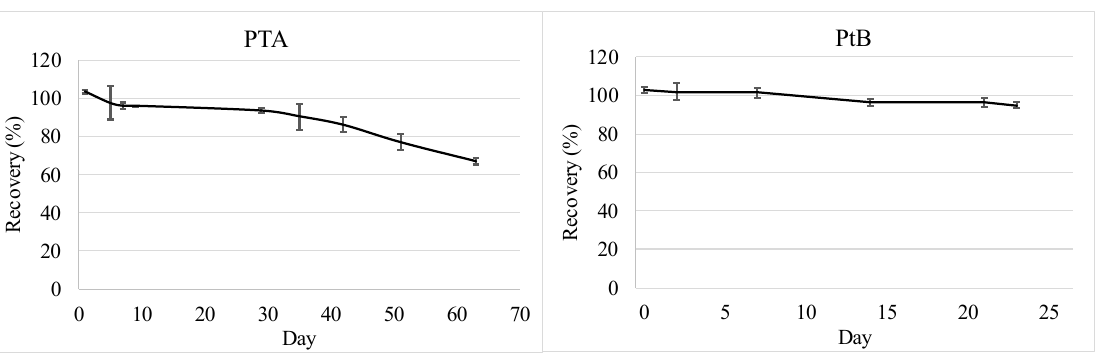
Figure 5. Stability of PTA (n = 2) and PtB (n = 6) in raw groundwater samples (Vigersted) at 4 °C handled according to the preservation protocol (95% confidence limit). The error bars represent relative standard deviation (RSD). The dots represent the measured data points, while the lines are linear interpolation between them.